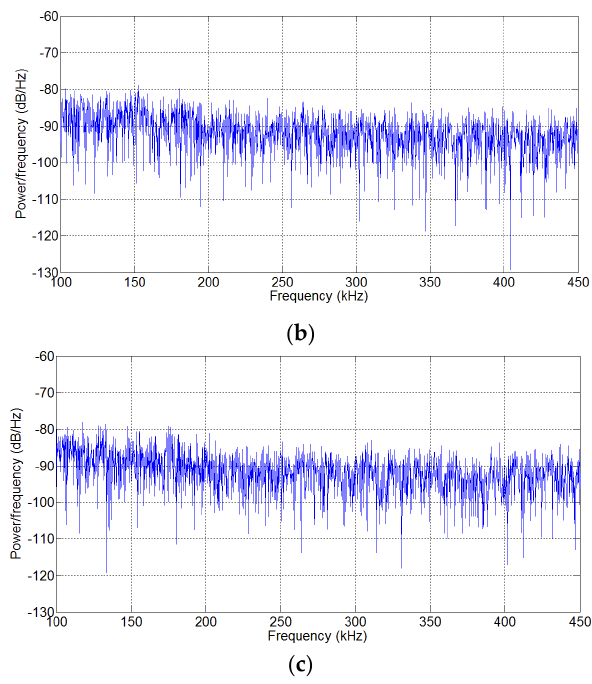
Figure 28. Measured power spectrum density of phase-shifted PWM control: ( a ) fixed switching-frequency; ( b ) continuously chaotic modulation; ( c ) discretely chaotic modulation.